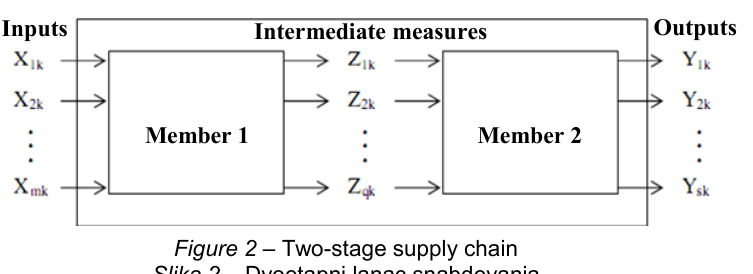
Figure 2 – Two-stage supply